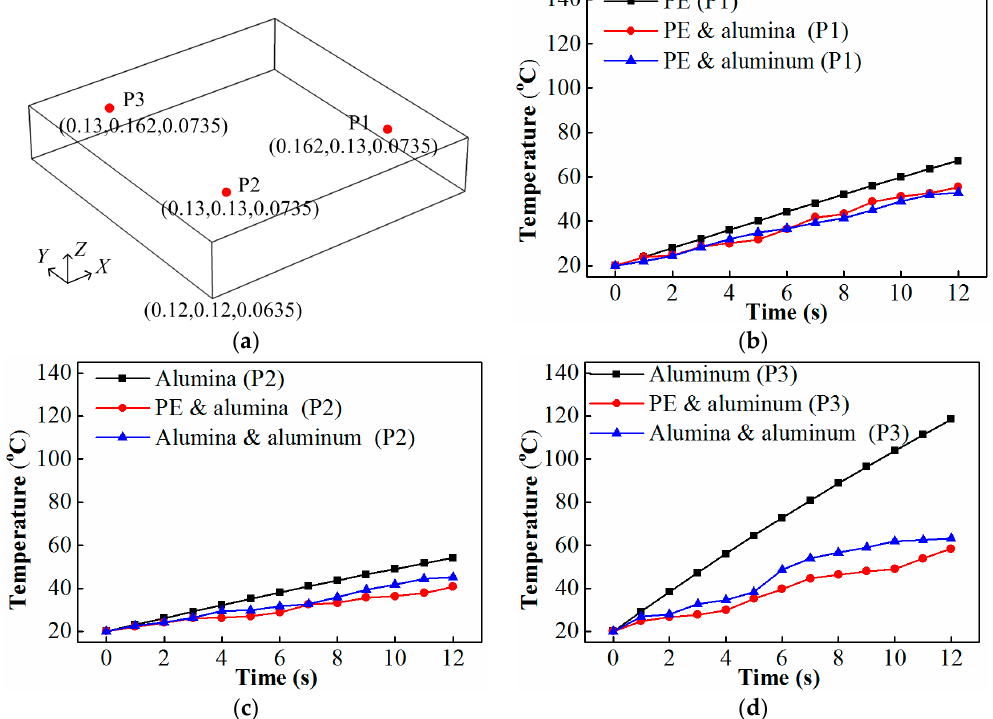
Figure 9. Hot spot analysis: ( a ) location of P1, P2, and P3 (unit: m); ( b ) temperature rise curve of P1; ( c ) temperature rise curve of P2; ( d ) temperature rise curve of P3.